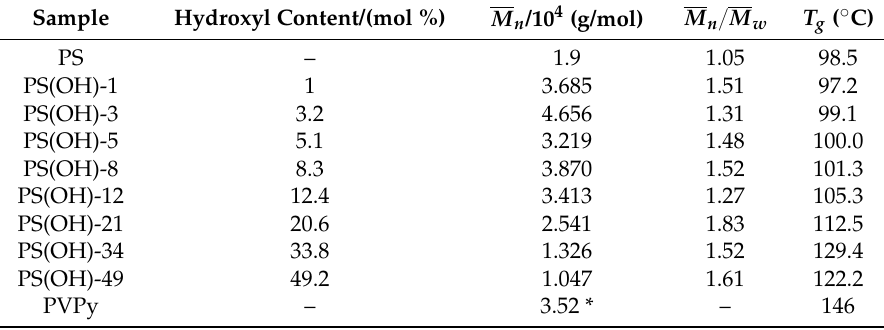
Figure 9. Calculated and measured T g s for the PS(OH)/PVPy blends or complexes as a function of the hydroxyl content in PS(OH) [21]. Table 3. Characteristic data of the PS(OH) copolymers and PVPy [20].